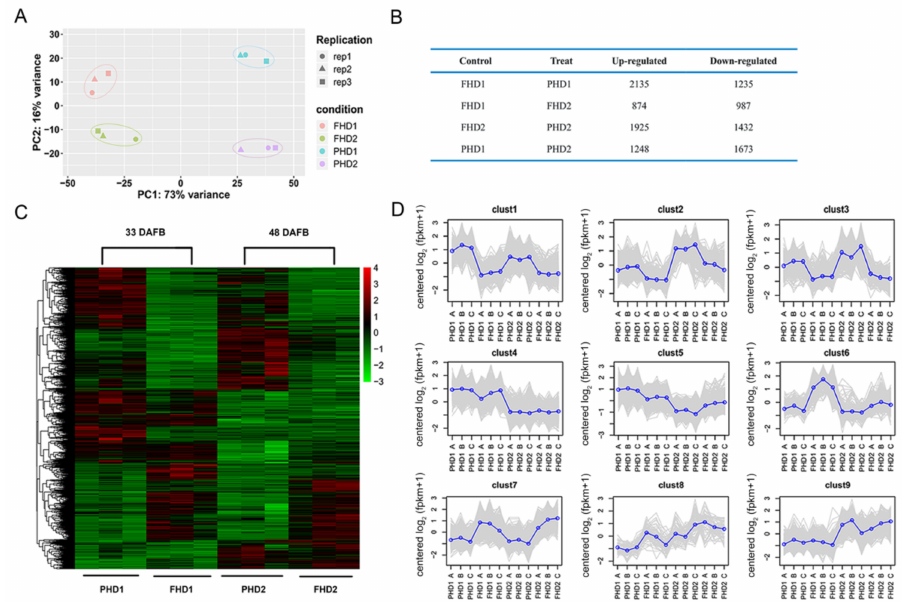
Figure 2. The RNA − seq expression profiles during ‘Hong Deng’ fruit development (33 DAFB and 44 DAFB) and in different parts (peel and flesh). ( A ) Principal component analysis of the RNA − seq data. ( B ) Numbers of differentially expressed genes (DEGs) in four groups. ( C ) Heatmap of transcrip- tome analysis of DEGs in ‘Hong Deng’. Red color indicates increased gene transcript levels; green color indicates decreased gene transcript levels. ( D ) Cluster trend analysis of significantly